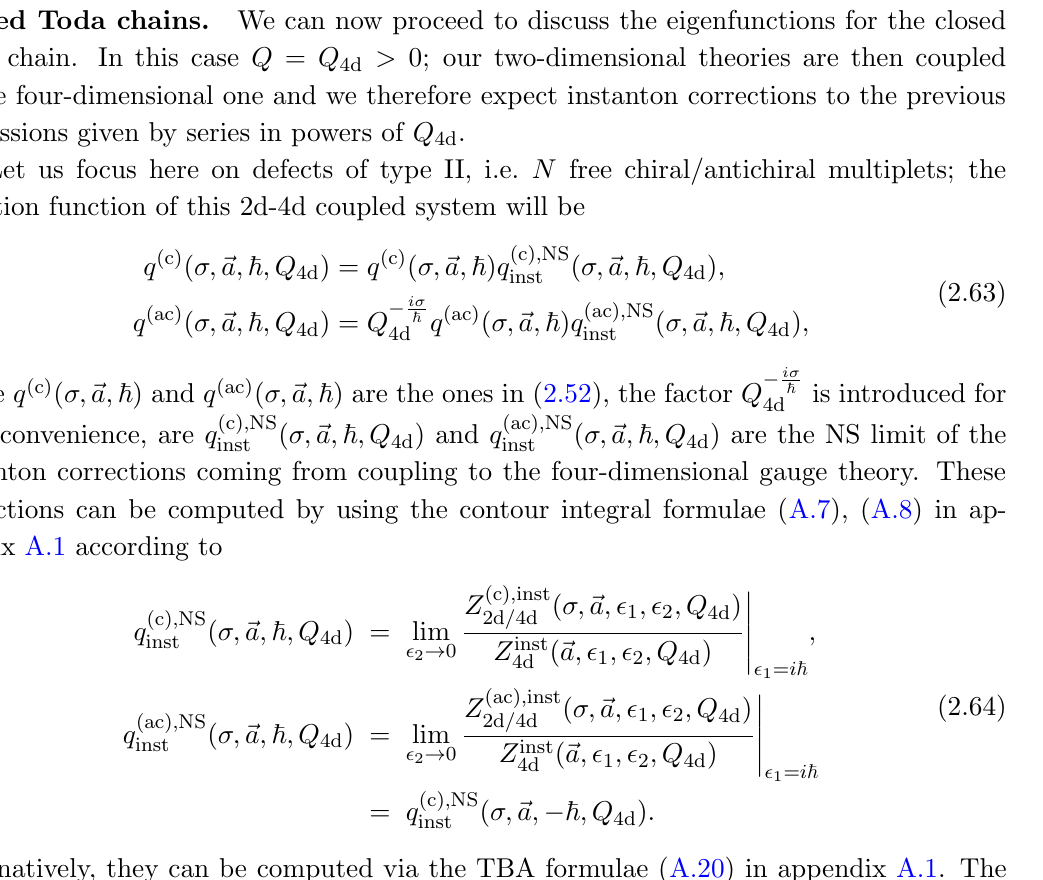
Figure 3. 2-particle open Toda eigenfunction (cid:9) (c) a ( x; ~ ) at ~ = 1 (left), ~ = p a = 1 : 4 ; 2 : 5 ; 1 : 702 (blue, orange, green); the potential e x is in red. Closed Toda